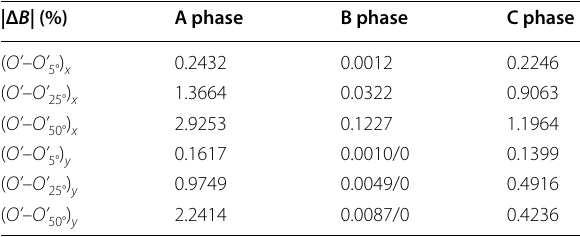
Table 2 Magnetic field errors at different angles